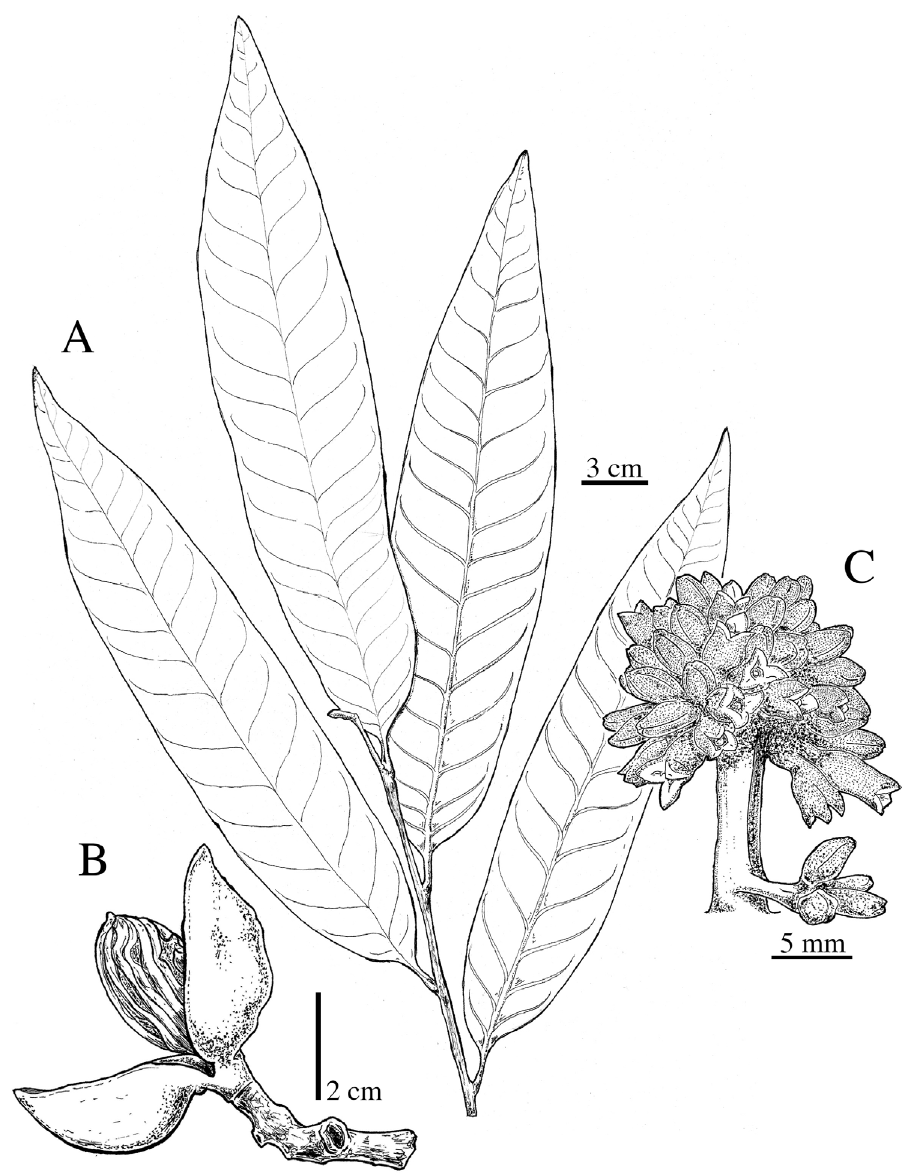
Figure 5. Virola allenii A leaves B fruit C partial inflorescences. Drawn by Pedro Juarez based on P. H. Allen 6727 ( A ), R. Aguilar 2224 ( B ) and R. Aguilar ( C ) from a photo, physical specimen not seen. constricted at the apex; anthers 0.6–0.9 mm long; apiculus 0.06–0.1 mm long, acute to apiculate, connate. Pistillate inflorescences and pistillate flowers not seen. In- fructescence 2.5–7.5 cm long, with 2–13 fruits, peduncle 2–3.5 × ca. 0.47 cm. Fruits 2.7–3.5 × 1.5–2.5 cm, usually ellipsoid or rarely ovoid, stipitate, densely